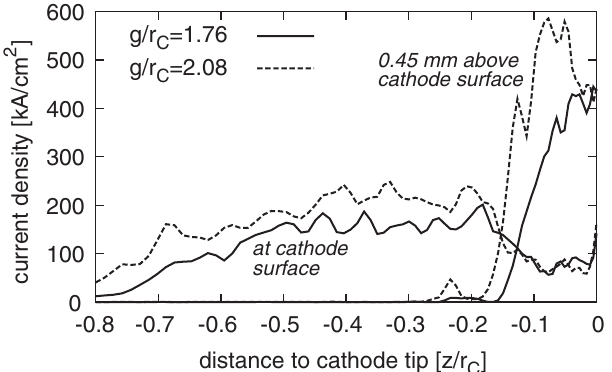
FIG. 8. Axial lineouts of the electron current densities along ¼ 1 : 76 (solid) and 2.08 (dashed) at the cathode cylinder for g=r C 40 ns into the driving pulse. Two lineouts are taken for each geometry (one adjacent to the cathode surface and one 0.45 mm above) which show the current to be less tightly bound near the cathode tip. Both simulations are of an Al þ anode